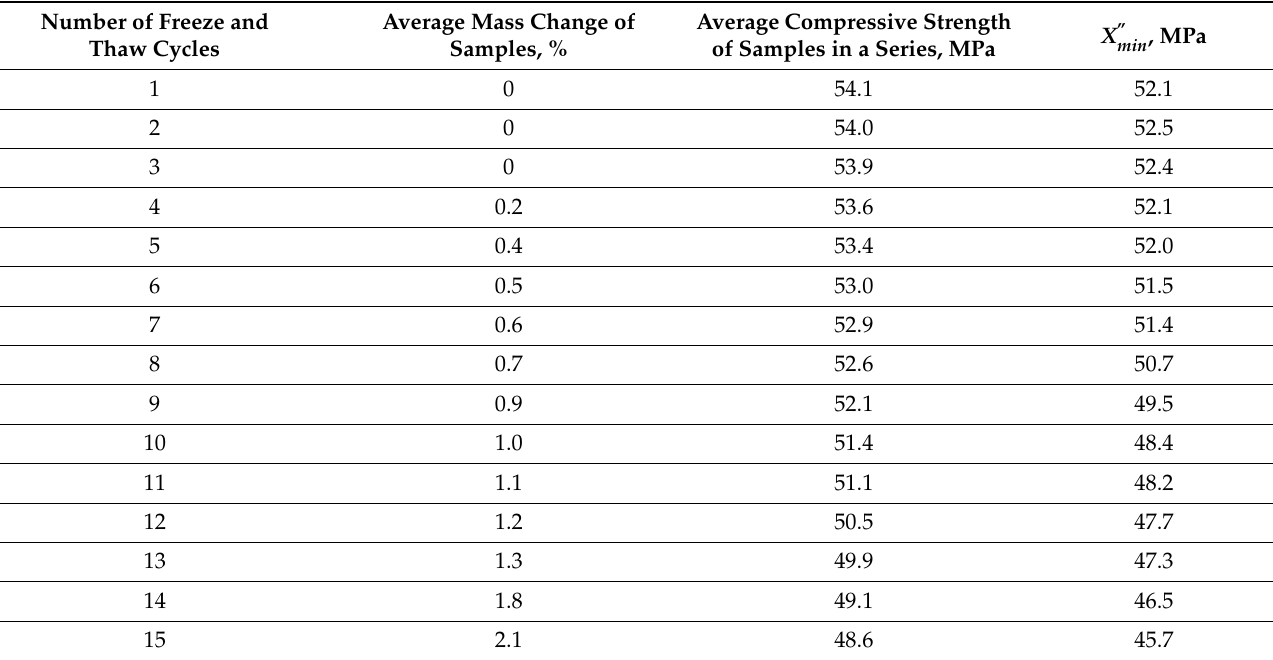
Table 11. Results of tests of vibrocentrifuged samples subjected to alternate freezing and thawing.